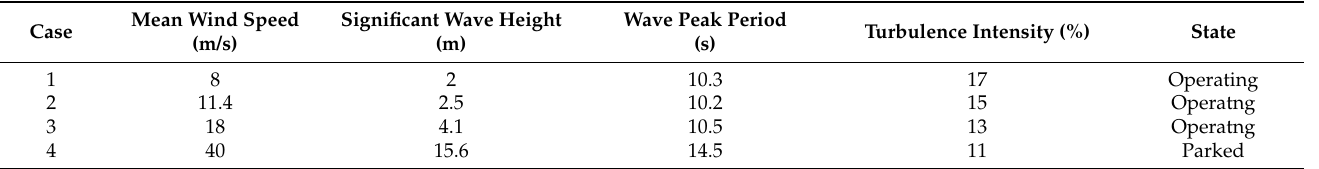
Table 8. Environmental conditions for